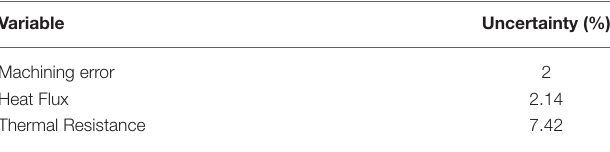
TABLE 3 | Experimental variables and uncertainty.